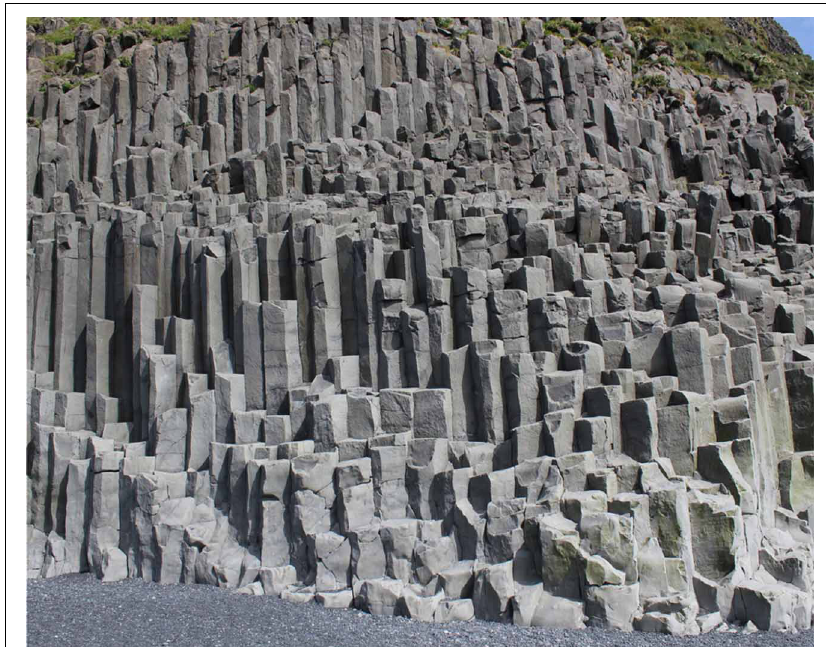
FIGURE 4 | Fault initiation and earthquakes. Most faults originate from existing weaknesses that, on an outcrop-scale, are commonly joints generated during the formation of the rock. View east, columnar (cooling) joints in a basaltic intrusion in South Iceland, with a common column diameter (width) of